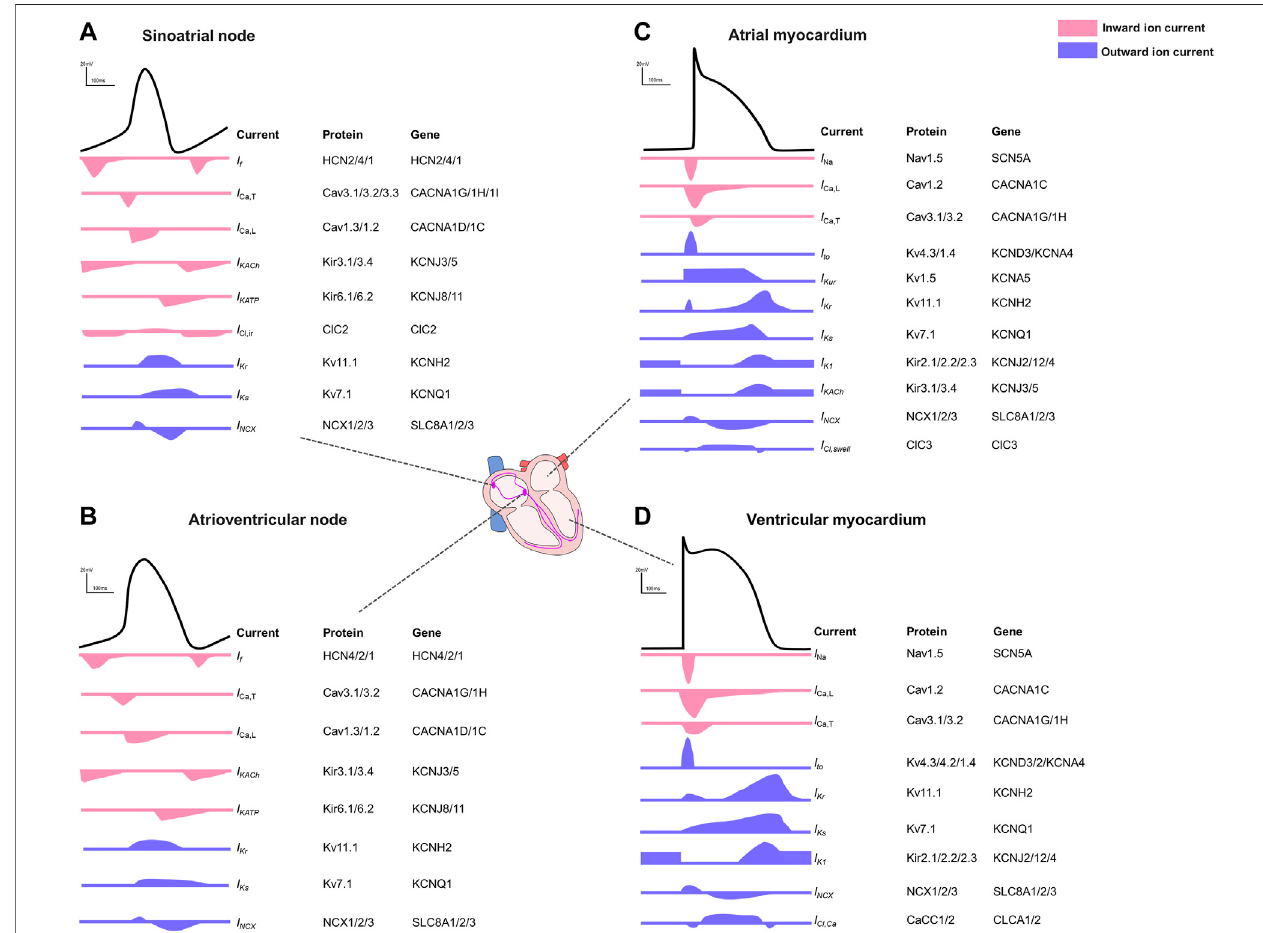
FIGURE 1 | Action potentials and the contributing ion currents in different regions of the human heart. (A) . Sinoatrial node. (B) . Atrioventricular node. (C) . Atrial myocardium. (D) . Ventricular myocardium.